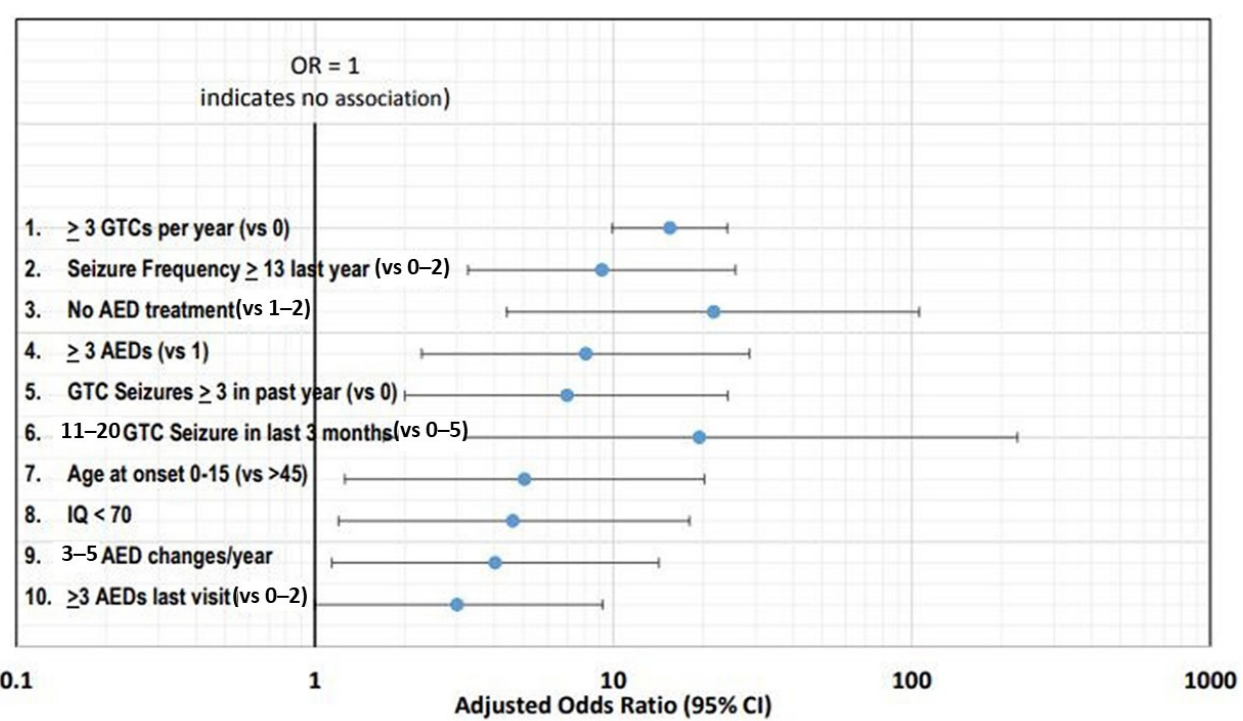
Figure 2. Top ten risk factors using adjusted ORs with corresponding 95% confidence intervals [16].